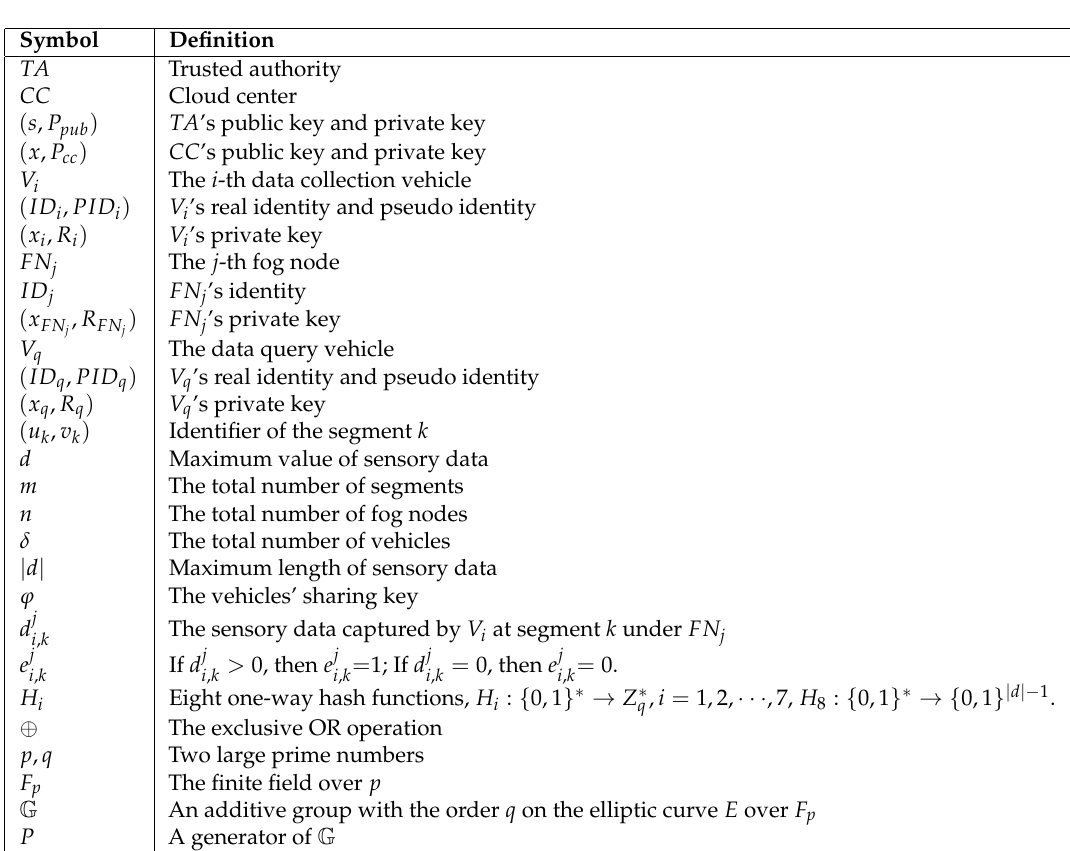
Figure 1. System model. Table 1.